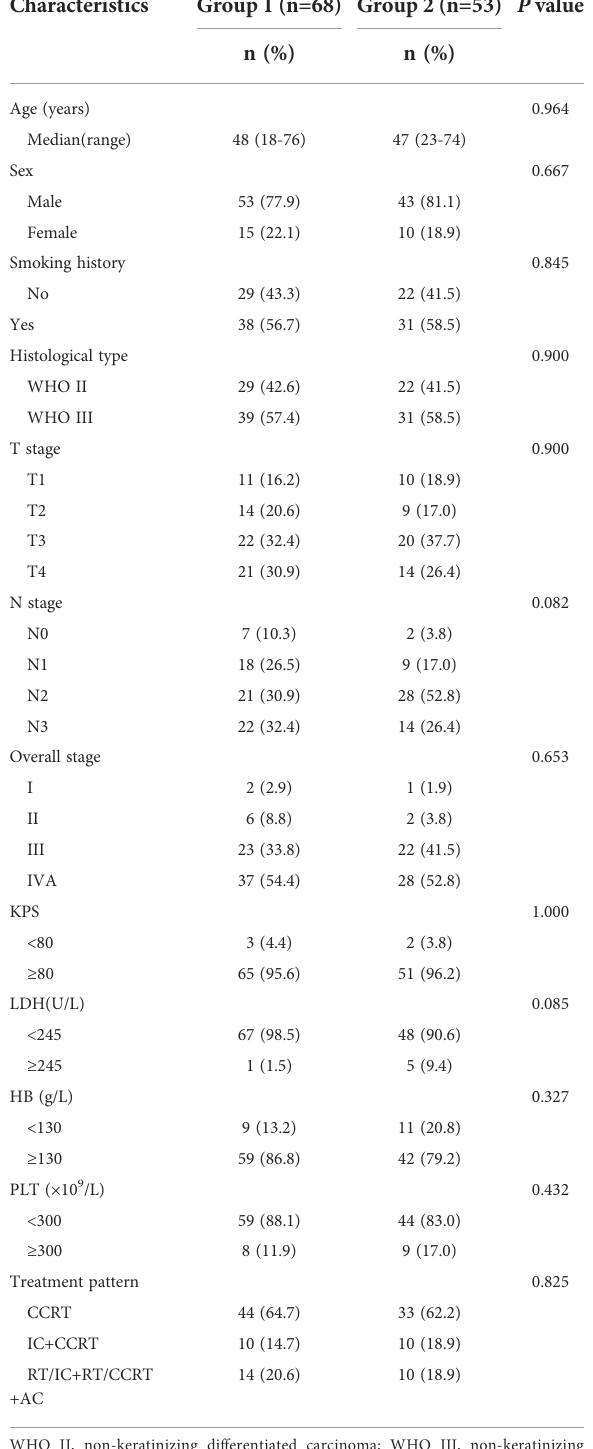
TABLE 1 General characteristics of patients in two